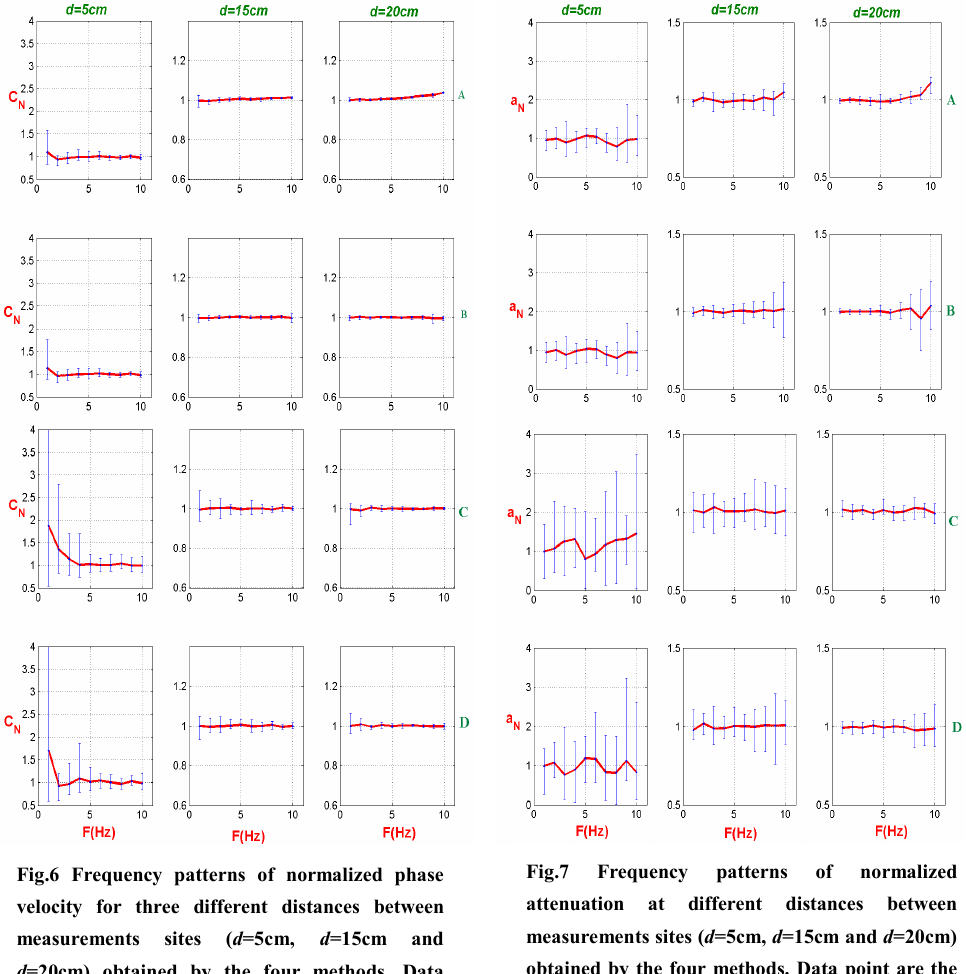
Fig.6 Frequency patterns of normalized phase velocity for three different distances between measurements sites ( d =5cm, d =15cm and d =20cm) obtained by the four methods. Data point are the mean and bars standard error of ten noise simulation.